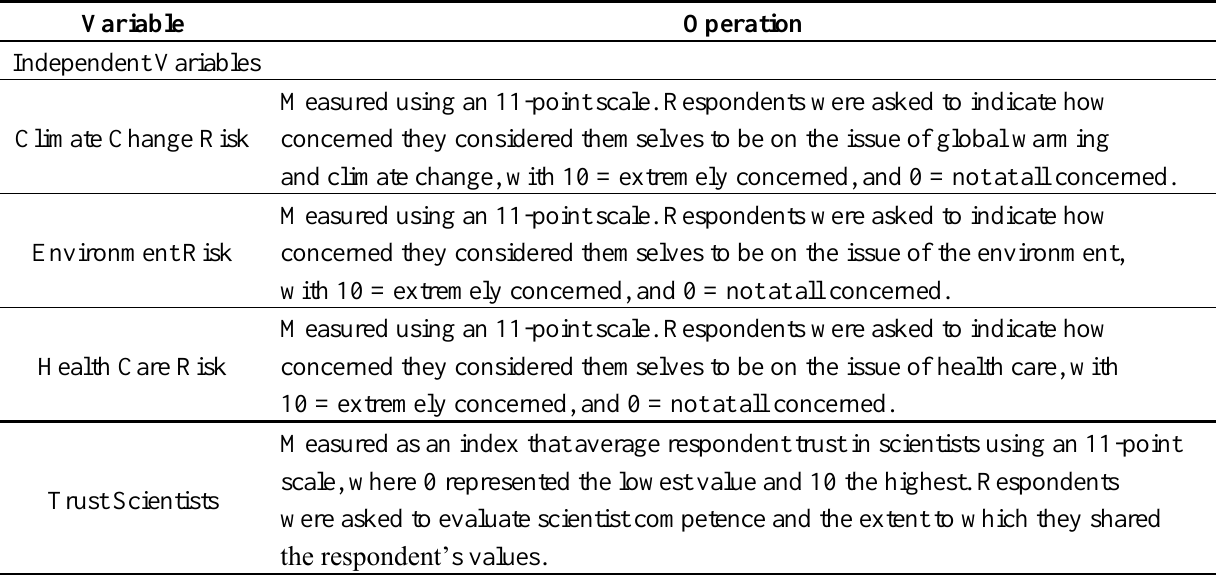
Table A1. Variable